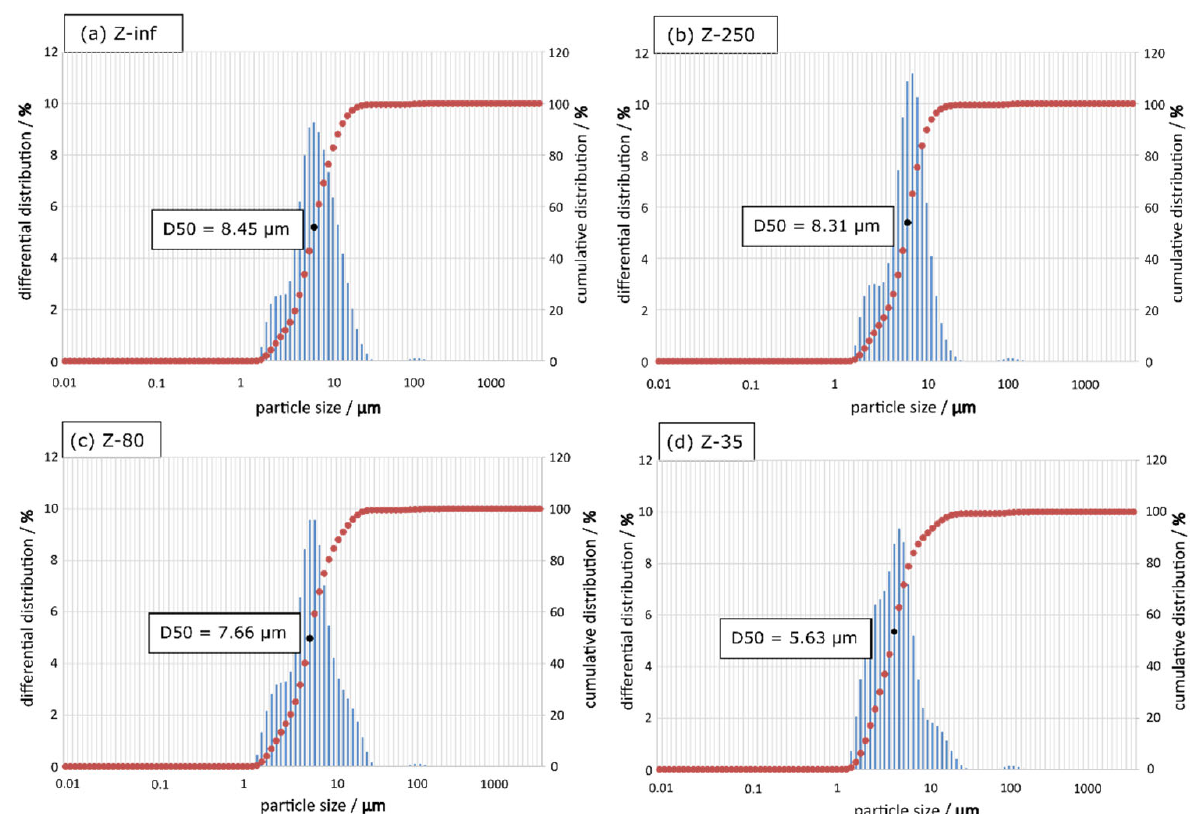
Figure 4. Comparison of particle size distribution of H-ZSM-5 zeolite samples by dynamic laser scattering: ( a – d ) samples Z-inf, Z-250, Z-80, Z-35; similar distribution, but from Si-rich (Z-inf) to Al-rich samples (Z-35) shift in main particle fraction towards smaller sizes, also visible within